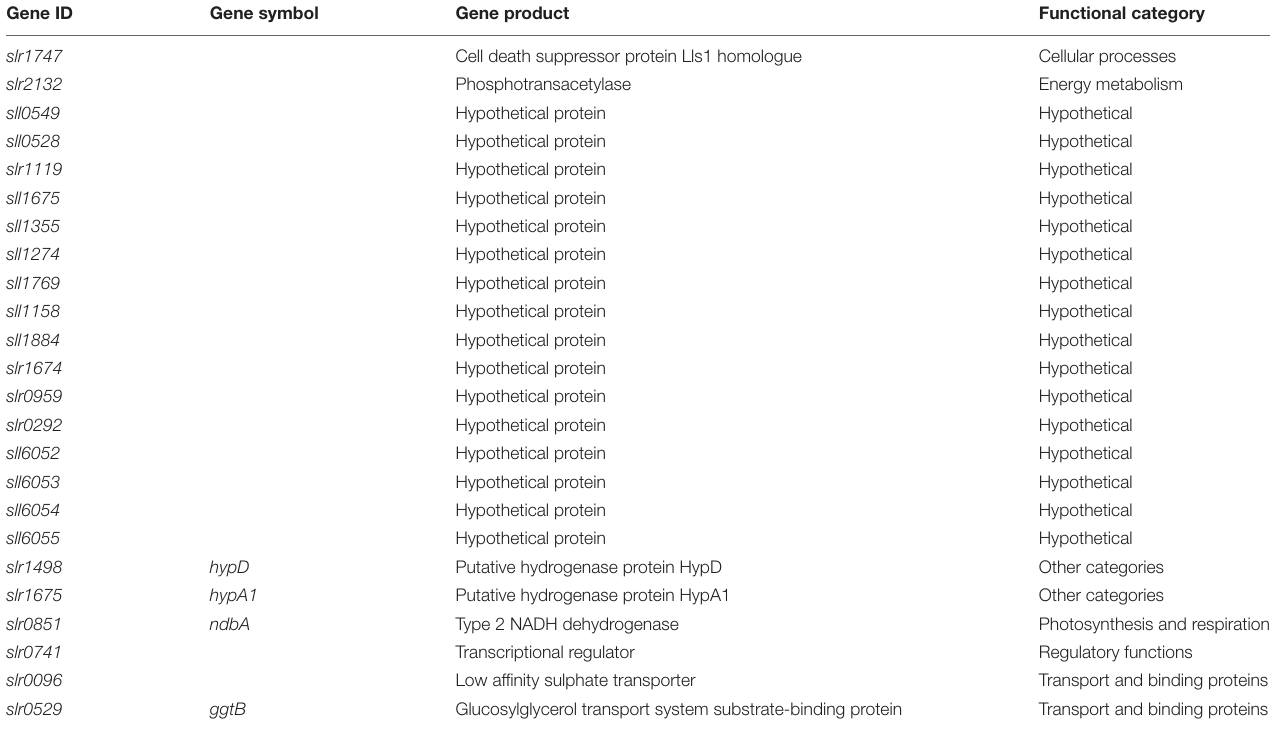
TABLE 2 | Late growth phase-specific genes of Synechocystis sp. PCC